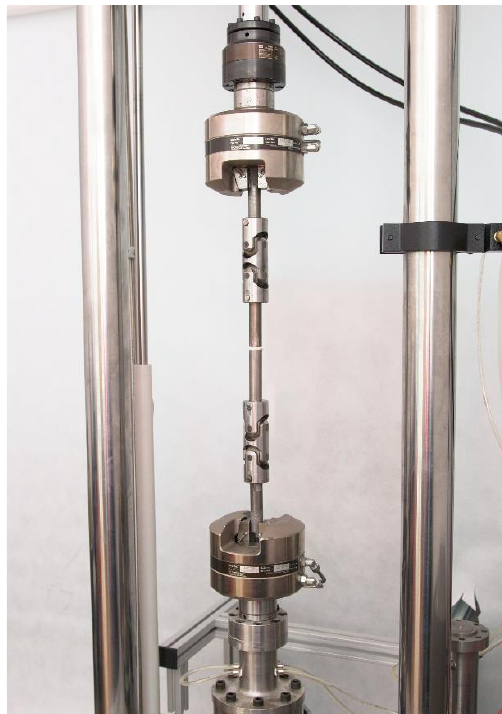
Figure 3. The adhesive specimen in the jointed fixture of the testing machine.